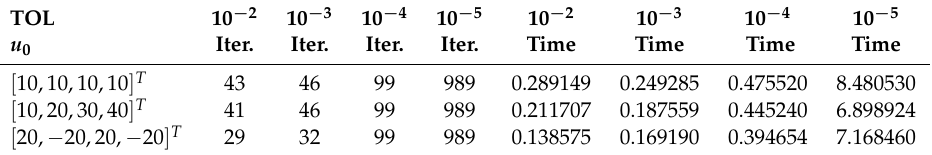
Table 2. Numerical behaviour of Algorithm 1 using different starting points for Example 2. TOL 10 −